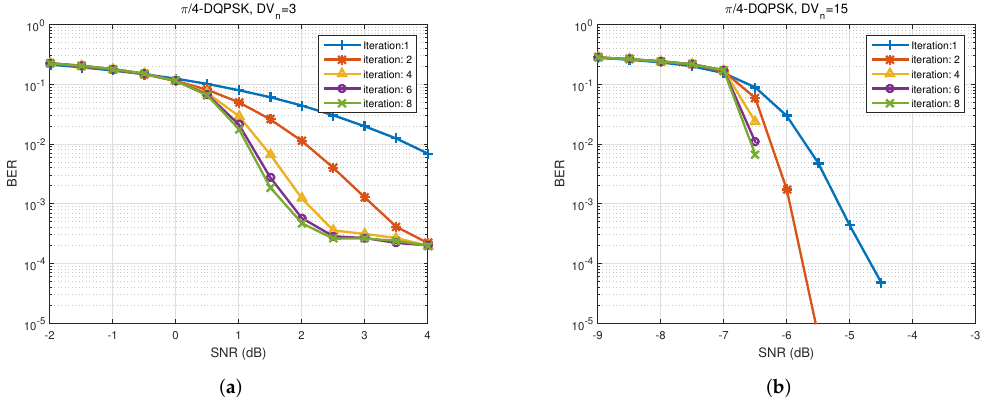
Figure 15. BER results for IoT PLC with π /4-DQPSK modulation: ( a ) DV n = 3; and ( b ) DV n = 15.